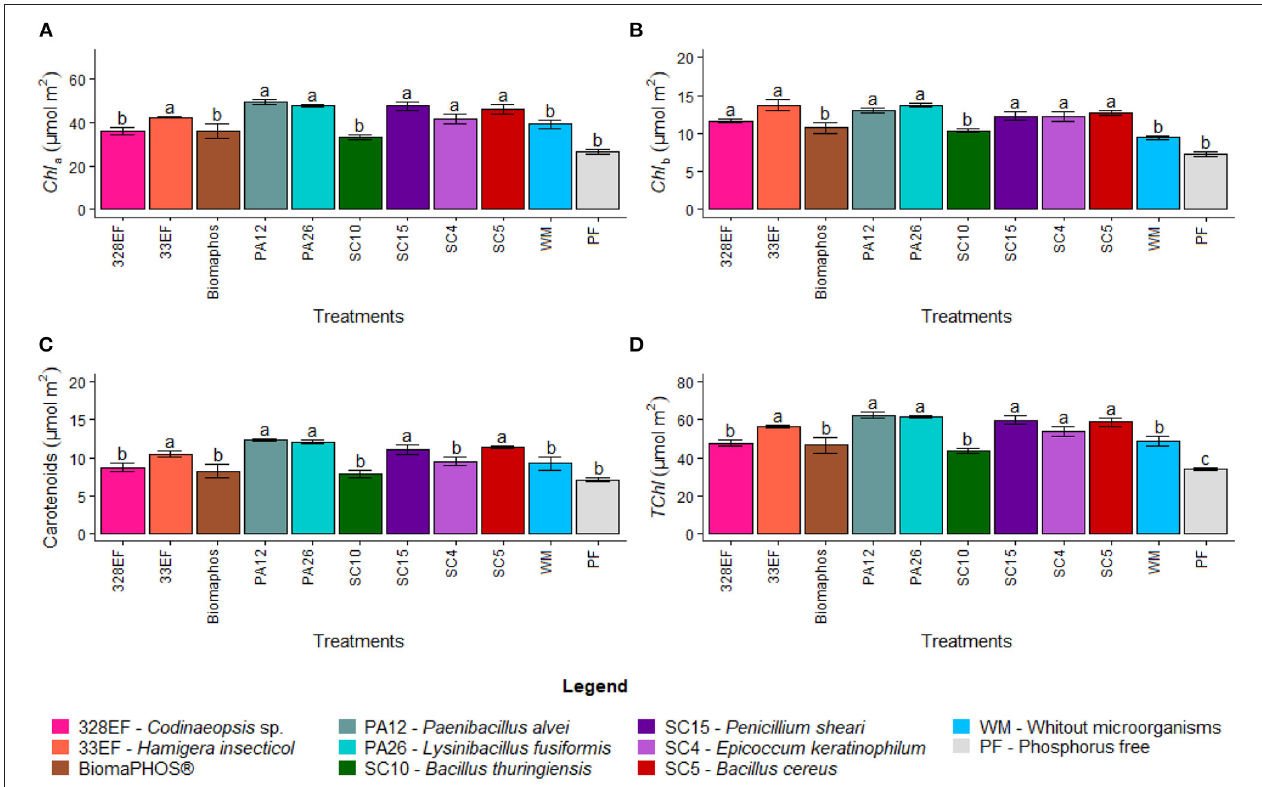
FIGURE 4 | Chlorophyll a content (A) , chlorophyll b content (B) , carotenoid content (C) , and total chlorophyll (D) in soybean plants ( G. max ) grown in nutrient solution providing calcium phosphate (CaHPO 4 ) as a phosphate source and inoculated with four bacterial strains and four fungal strains. Means followed by the same letter do not differ from one another according to the Scott-Knott test at 5%